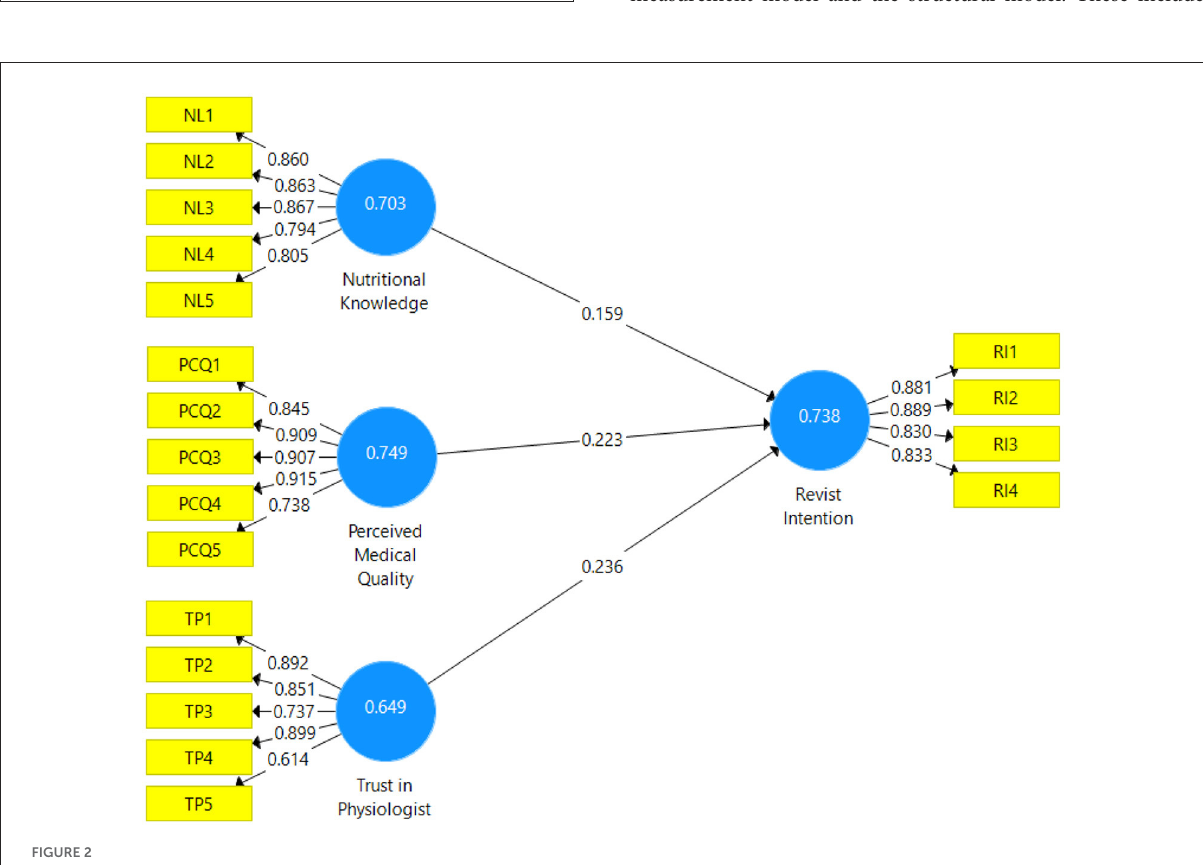
FIGURE2 Measurement model.